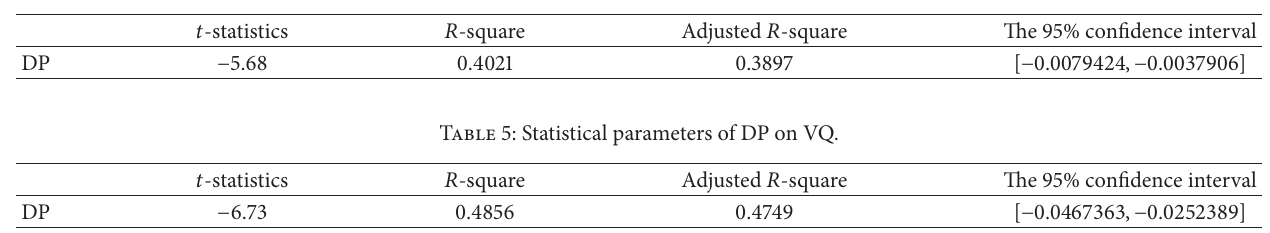
Table 4: Statistical parameters of DP on MQ.